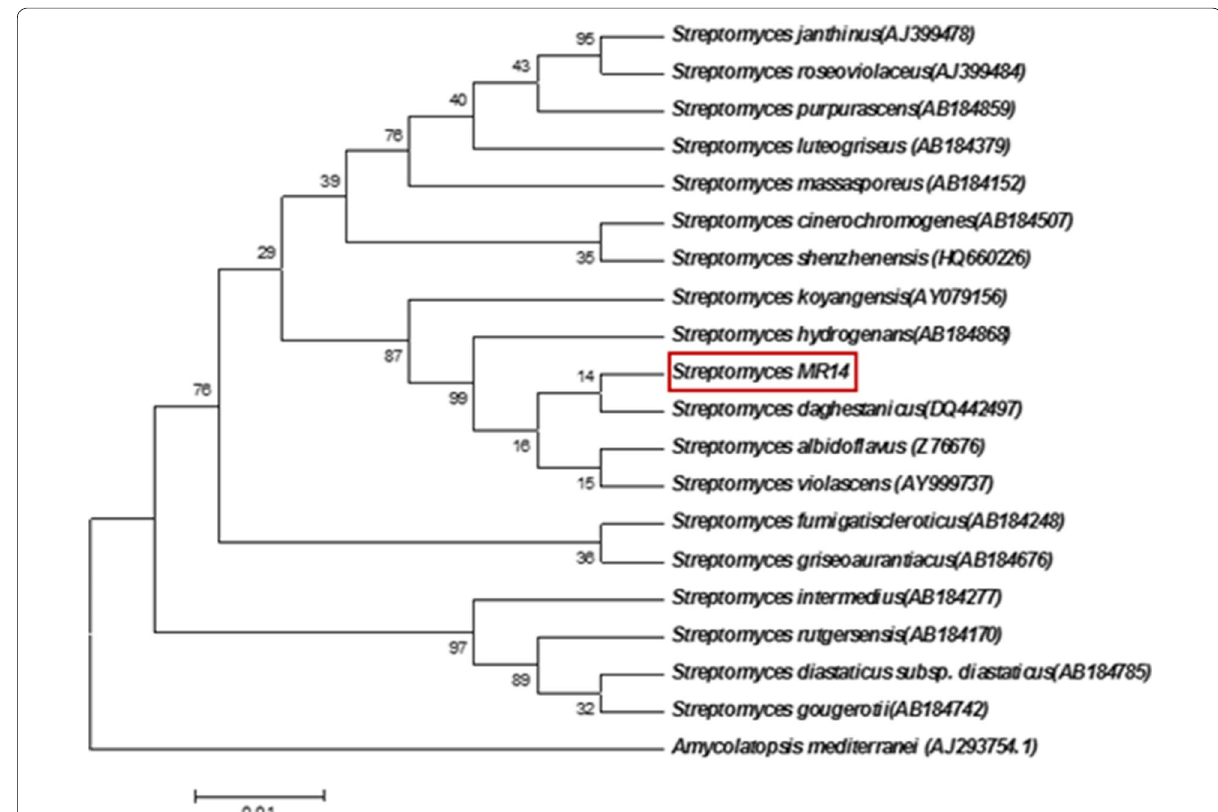
Fig. 2 Neighbor-joining tree based on nearly complete 16S rRNA gene sequences showing the position of isolate Streptomyces sp. MR14 amongst its phylogenetic neighbors. Bootstrap values (expressed as percentages of 1000 replications) are shown at the nodes. Amycolatopsis mediterranei (AJ293754.1) was used as an outgroup. GenBank accession numbers are given in